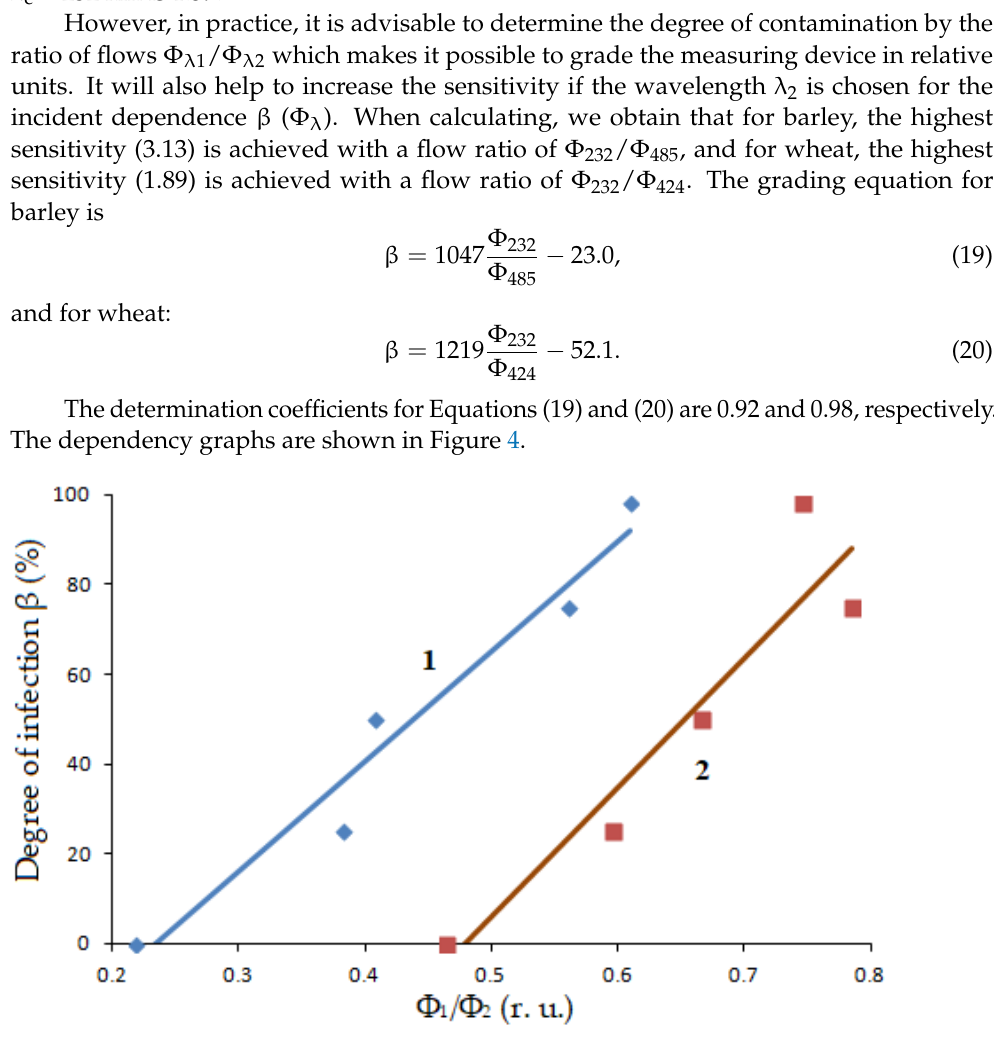
Figure 4. Dependences of the degree of contamination of barley (1) and wheat (2) seeds on the ratio of flows.